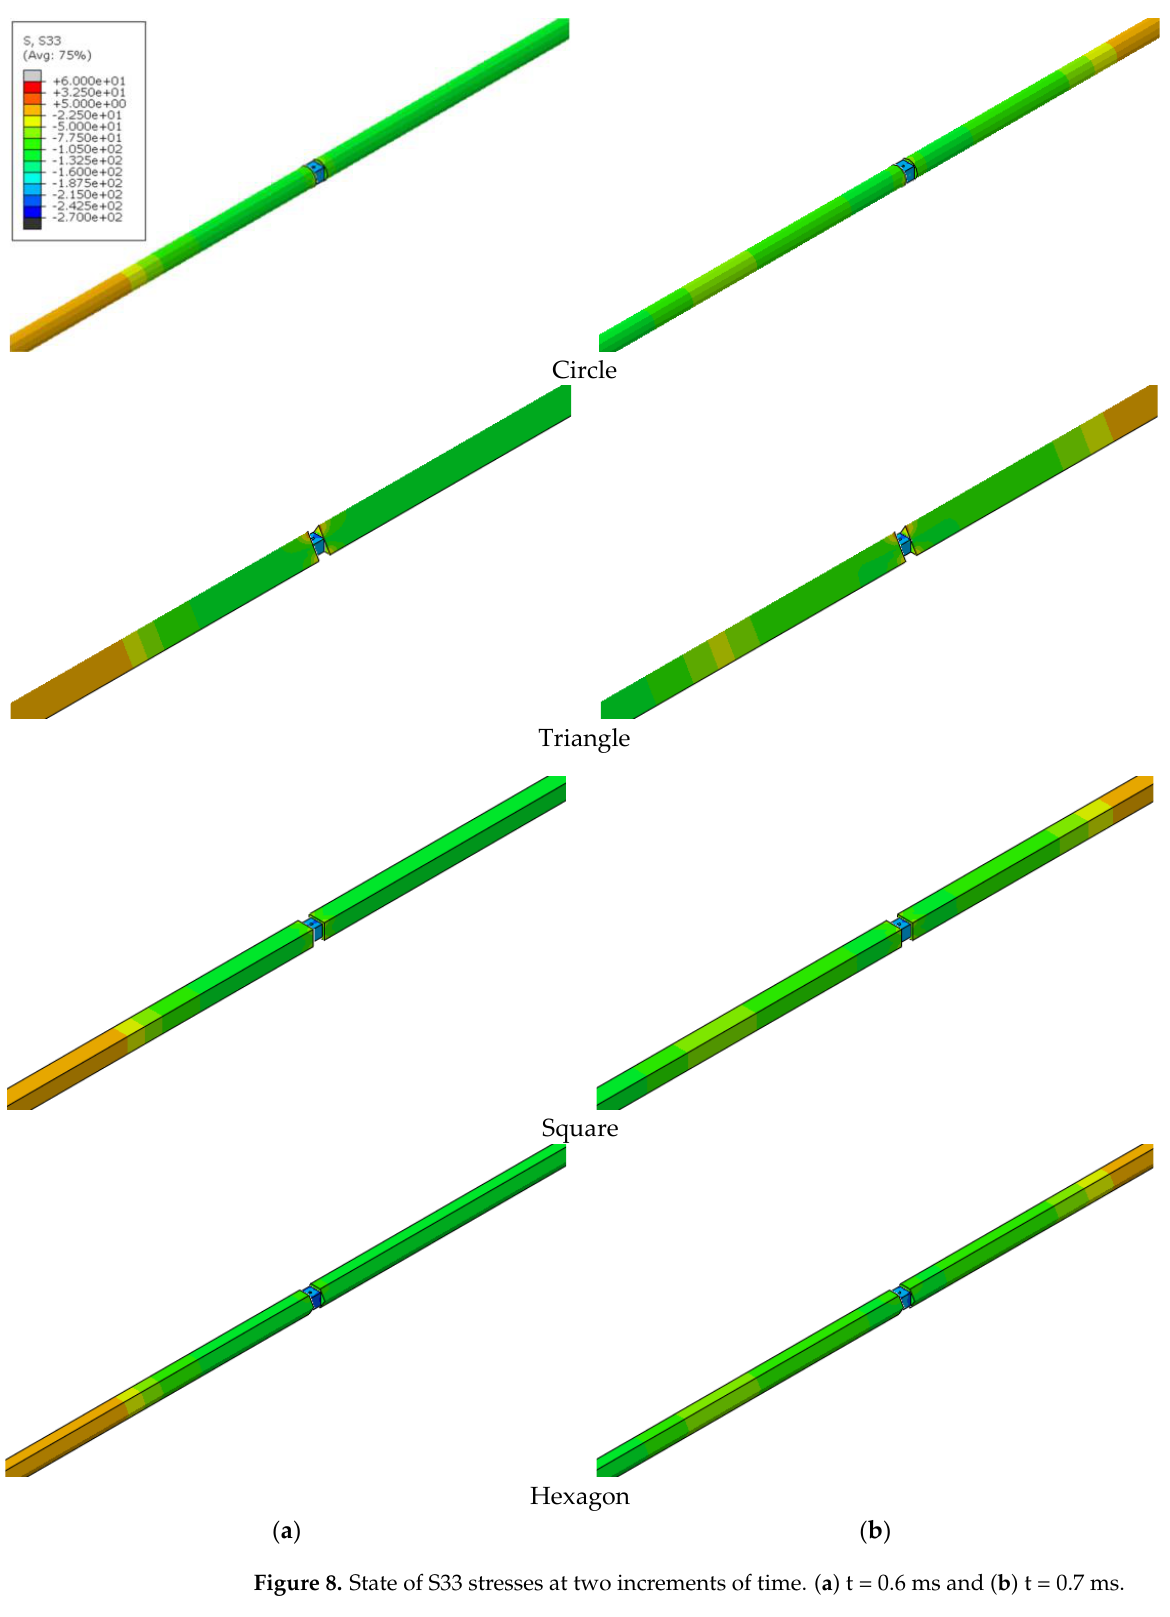
Circle Triangle